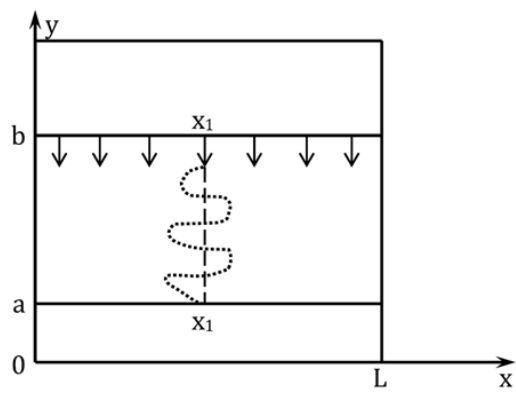
Figure 1. 2D model of the cross-section of the area perpendicular to the plane in which the particles emitted from the cathode in the direction of the substrate are being deposited.